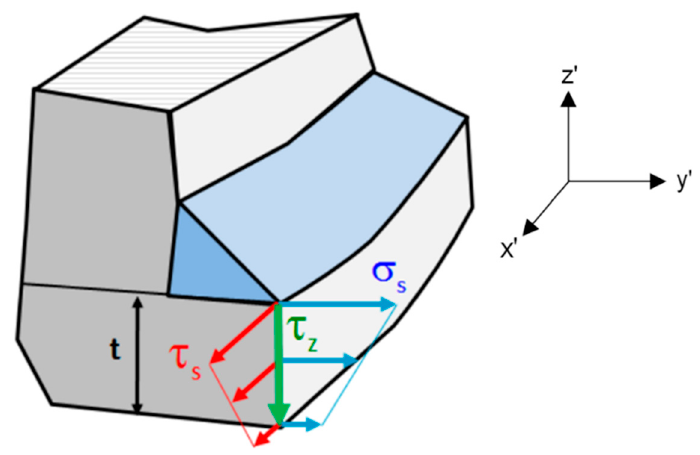
Figure 3. Structural stress components at the weld toe (adapted from [45]).